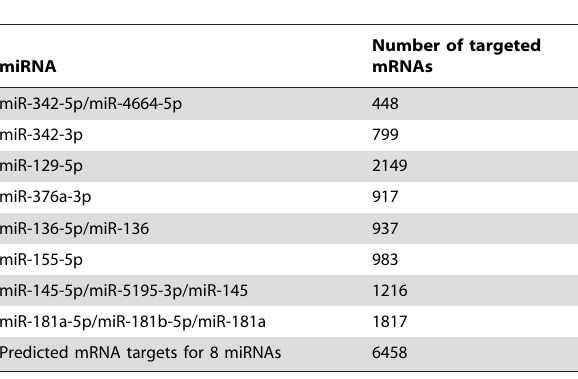
Table 2. Predicted targets of the eight microRNAs (in total 6,458 mRNAs, from